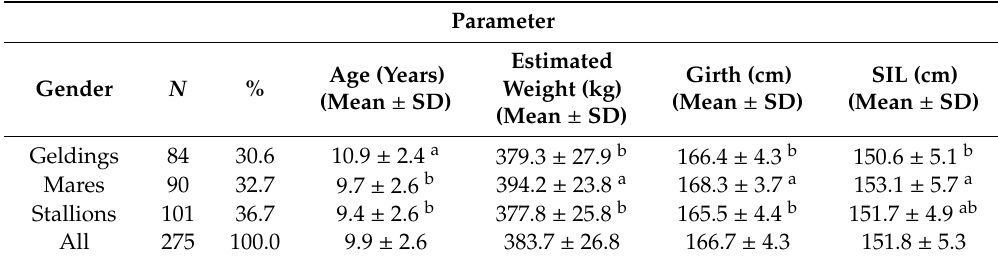
Table 1. Characterization of horses included in the survey, concerning gender, age, and estimated weight calculated from the girth and scapula–ischial length (SIL).